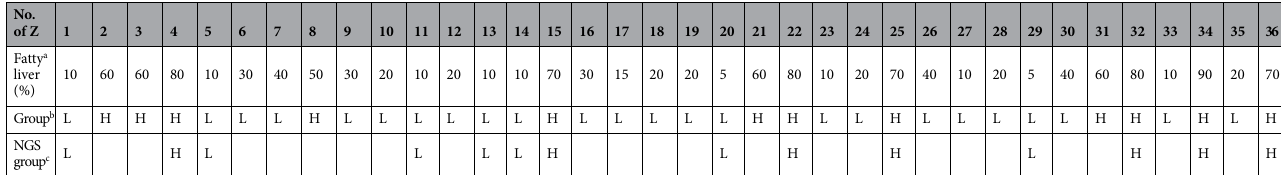
mentary data 2. Among 5065 genes, 1772 genes were upregulated and 3293 genes were downregulated with sta- tistical significance (Fig. 3a,b). The smear plot and volcano plot between the high- and low- fatty change groups are featured in Fig. 3c,d. We selected 548 lncRNAs that had a greater than twofold change, either downregulated or upregulated, than the control group with statistical significance with a p-value of less than 0.05. Then, we chose 28 downregulated and 8 upregulated lncRNAs that had greater than tenfold changes than the control group with p-values of less than 0.05 (Fig. 3b). The identified 28 lncRNAs are listed in Table 2. Identification of human homologs of eight long noncoding RNAs of zebrafish. To obtain the human homologs of each lncRNA of the NAFLD zebrafish, we performed ZFLNC BLAST and NCBI FASTA. First, in the NCBI section, we copied the sequence of the lncRNA and put it in the BLAST section of ZFLNC. The genes with the highest score were designated human homologs of the specific lncRNAs. Eight (ZFLNCT18125,